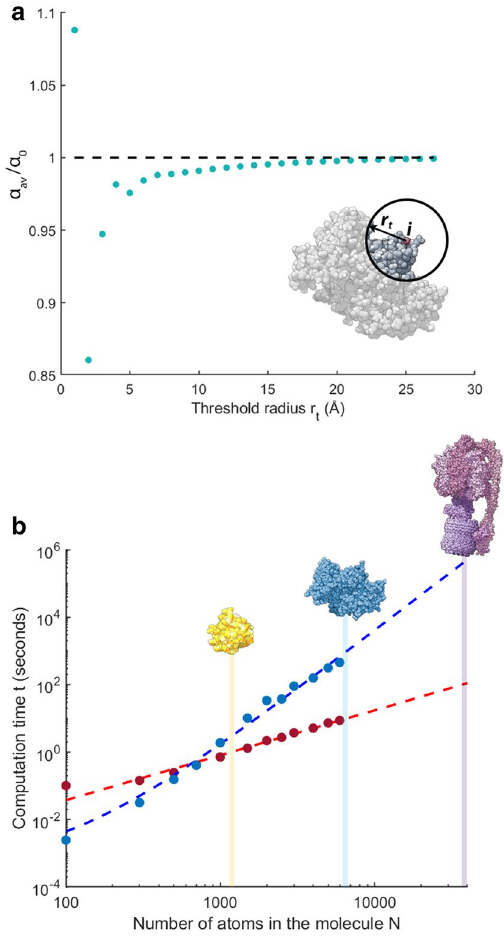
Figure 3. ( a ) Threshold radius versus average molecular polarizability ( α av ). α 0 is the average polarizability of BSA [PDBID: 3V03] 40 with no threshold radius applied. ( b ) Comparison of the time taken to